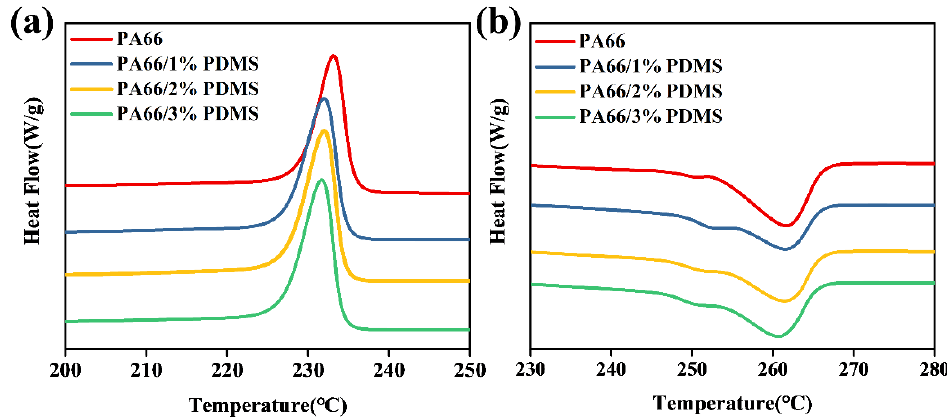
Figure 2. Crystallization ( a ) and melting ( b ) of PA66/PDMS blends.